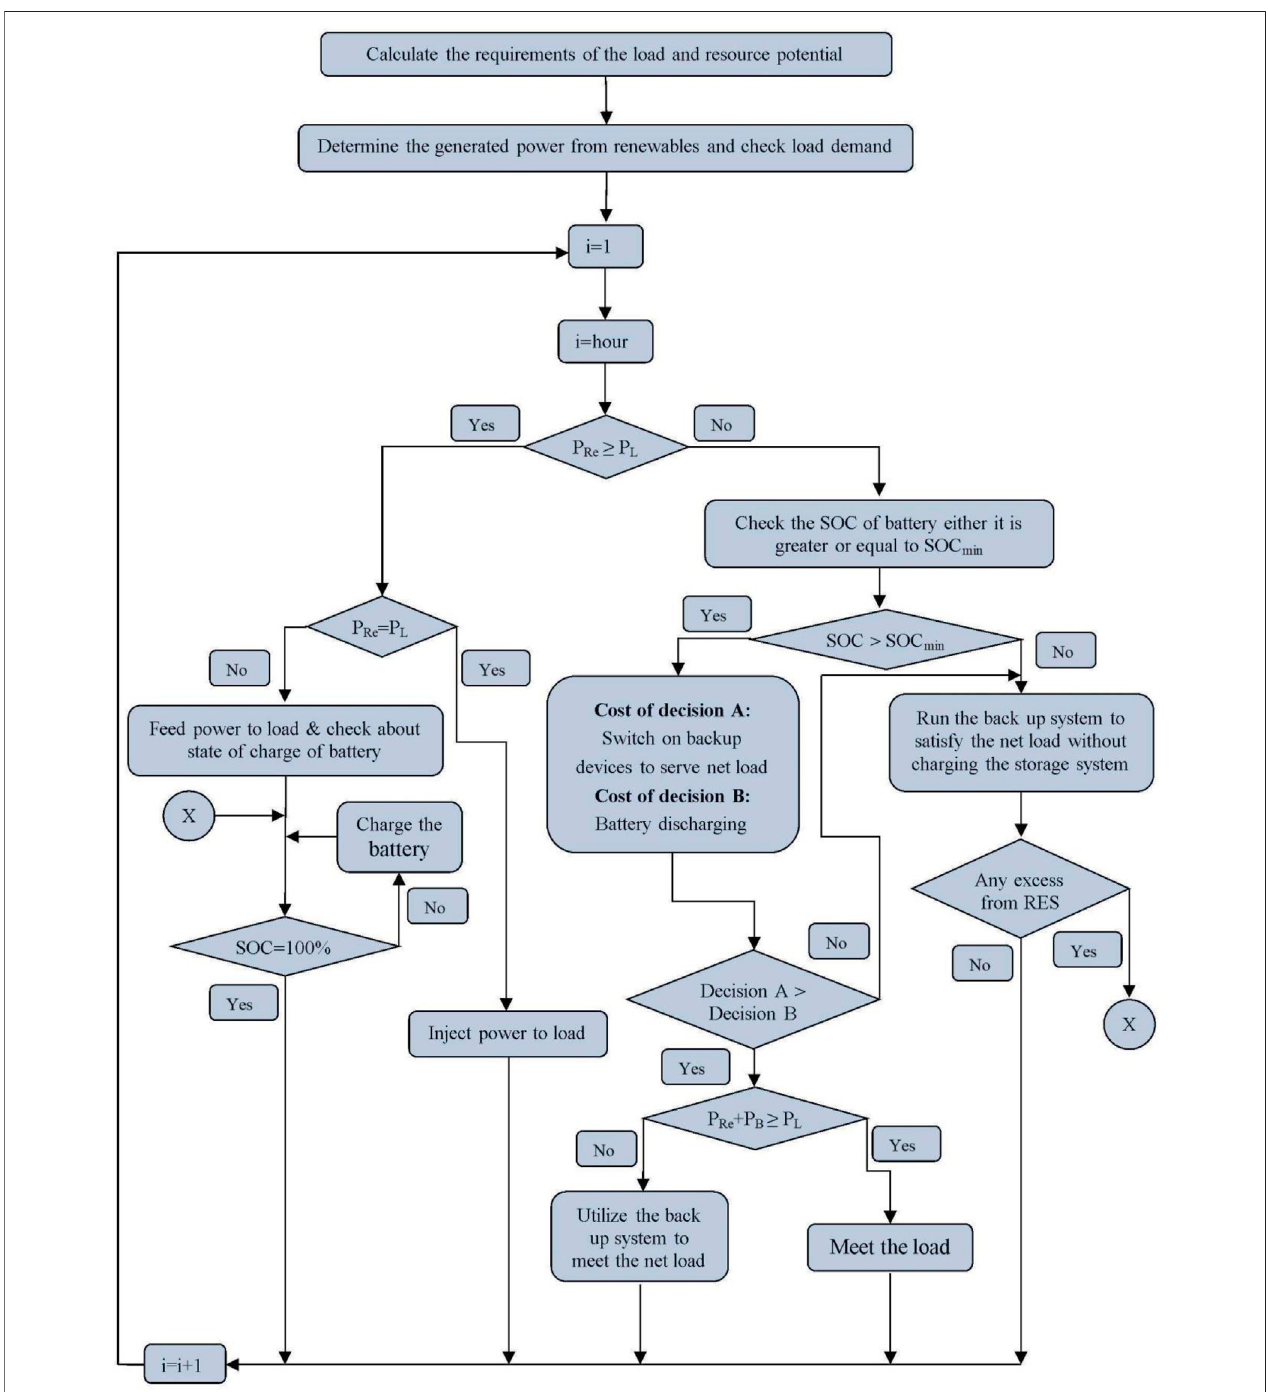
FIGURE 4 | Diagrammatic representation of load-following dispatch